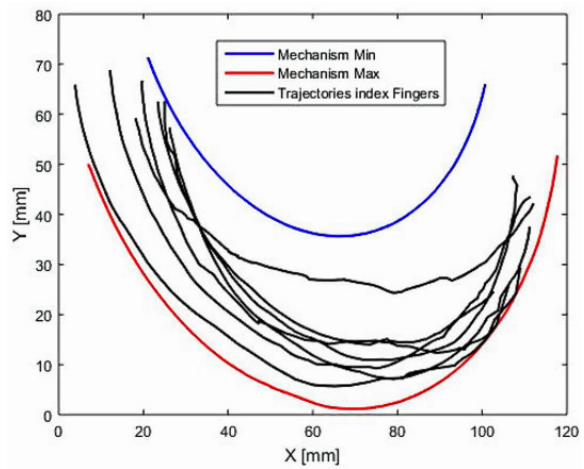
Figure 15. Workspace trajectories and index fingers.